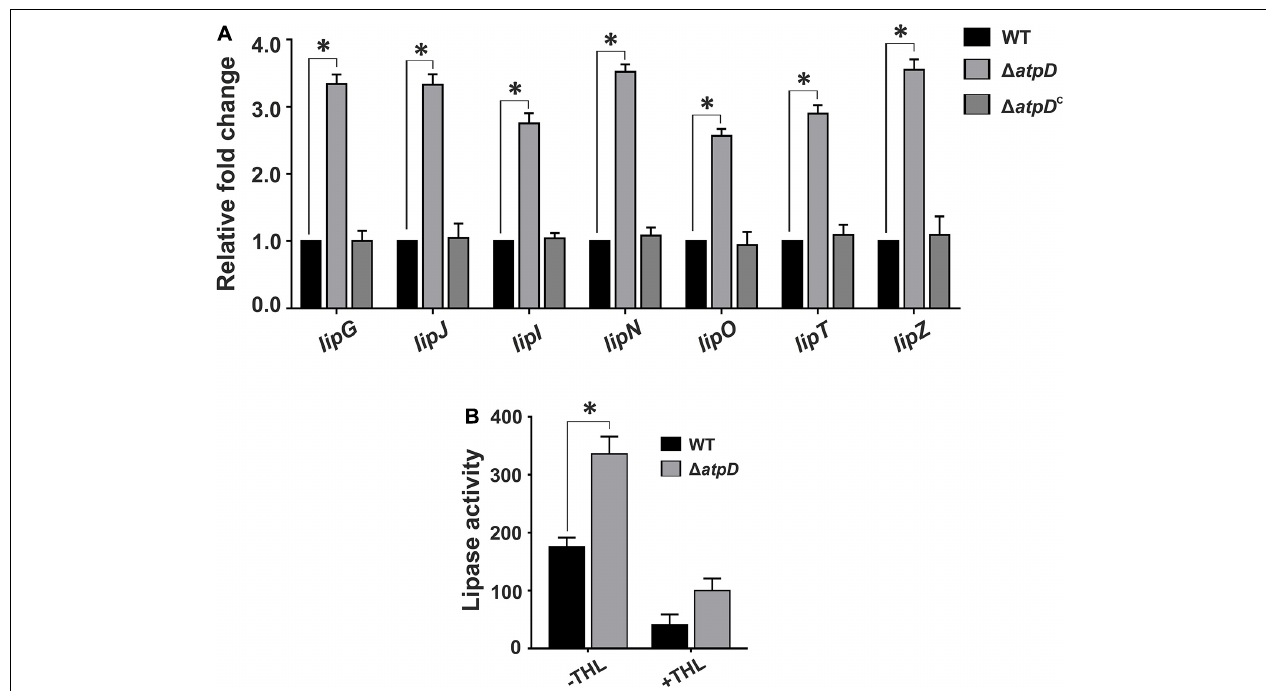
FIGURE 6 | Mycobacterium smegmatis (cid:49) atpD shows higher lipase gene expression coupled with an increased lipase activity. Panel (A) shows the relative mRNA transcript levels of the lipase genes ( lipG, lipJ, lipI, lipN, lipO, lipT , and lipZ ) in M. smegmatis wild-type (WT), atpD knock out ( (cid:49) atpD ), and atpD -complemented ( (cid:49) atpD C ) strains. The transcript level in each case is compared with that of M. smegmatis wild-type, which is taken as 1. Panel (B) shows the lipase activity in M. smegmatis WT and its atpD knock-out ( (cid:49) atpD ) variant measured in the absence (–THL) and in the presence (+THL) of lipase inhibitor tetrahydrolipstatin (THL). In both the panels, data represent an average of at least three independent experiments with error bars depicting standard deviation. ∗ P -value <